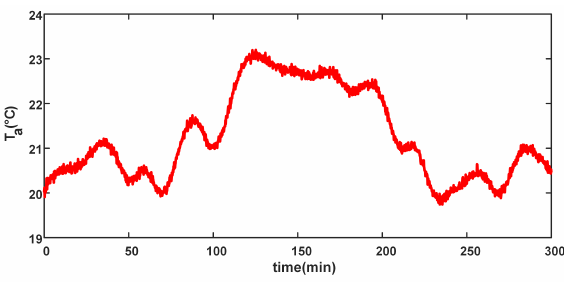
Fig. 3. Ambient temperature change curve.